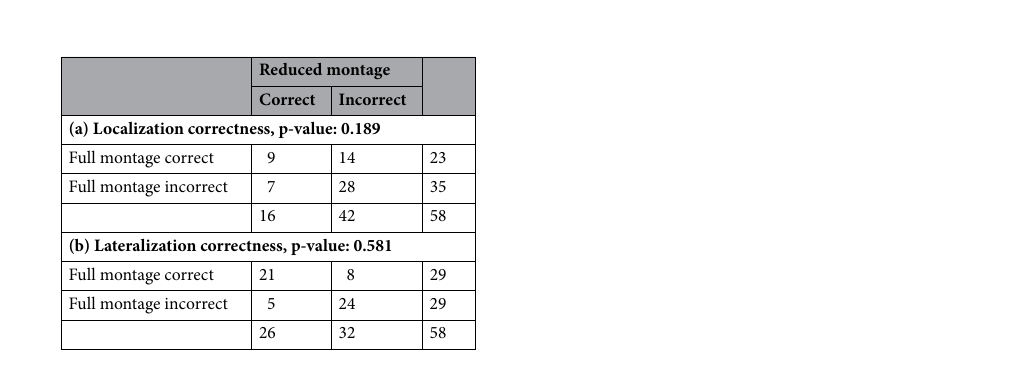
Table 3. The contingency tables show the frequencies of correct localization and lateralization compared to the original EMU classifications.